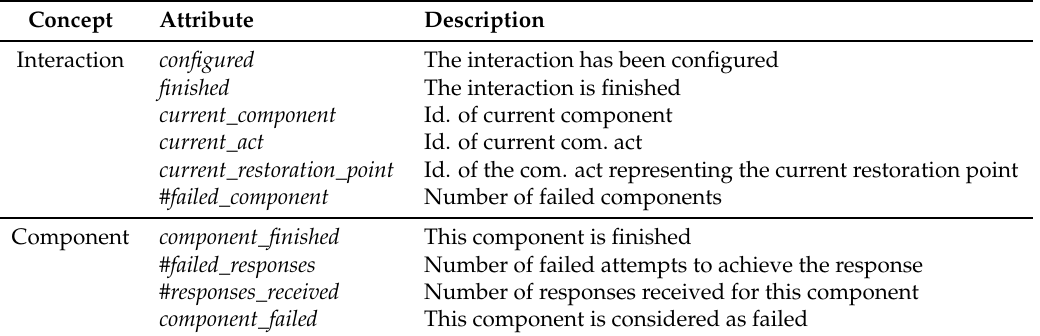
Table 2. Description of internal attributes.